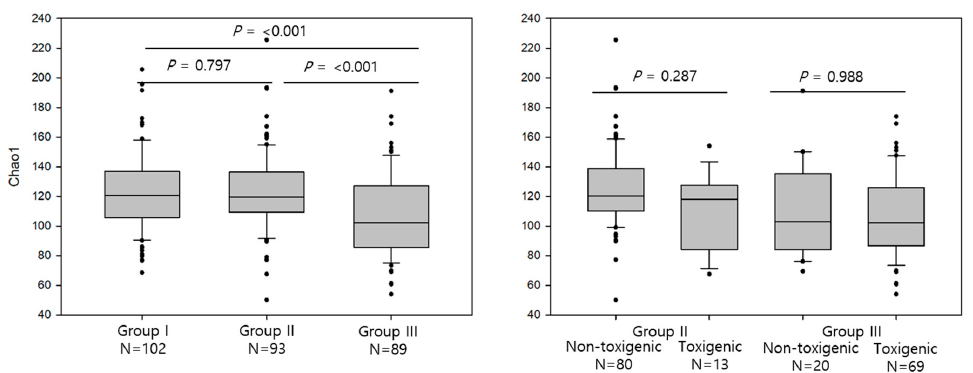
Figure 1. Alpha diversity (Chao1 index) in group I ( C. difficile non-colonized), group II ( C. difficile colonized), and group III (diarrhea with C. di ffi cile ) are shown in left and the comparisons between